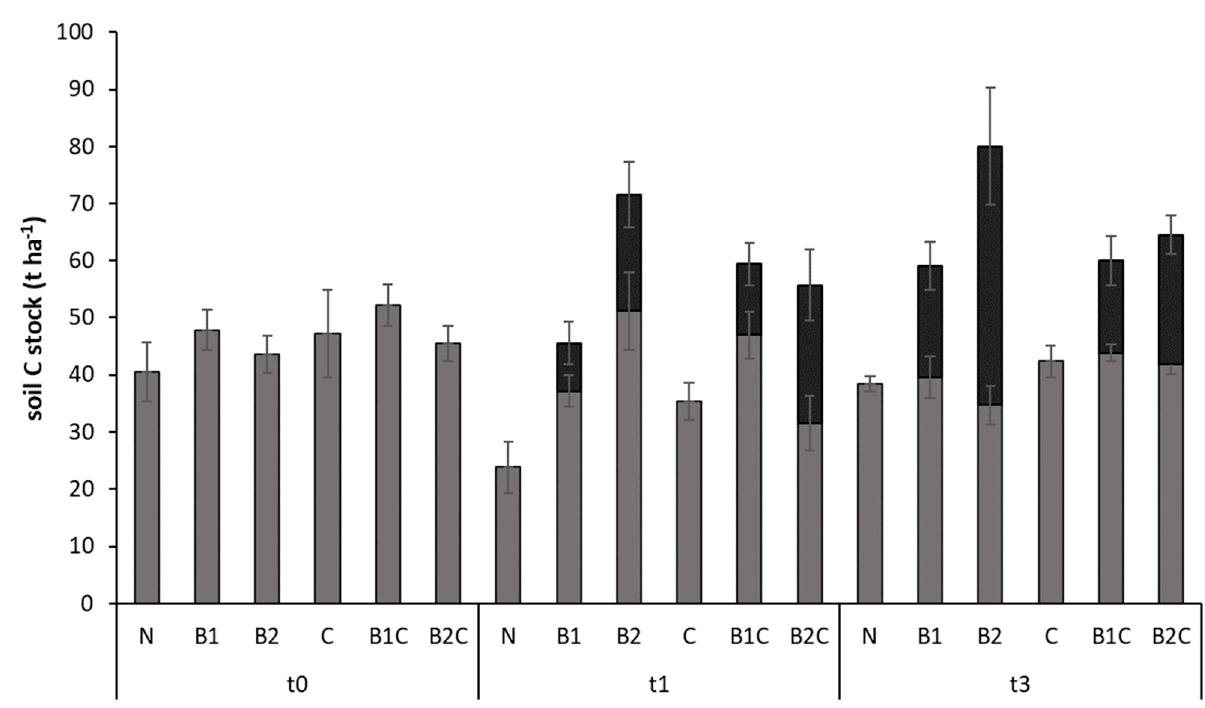
Figure 7. Soil C stock (t ha − 1 ) divided into biochar-C (black bars) and SOM-C (gray bars) as assessed with the BPCA method. C stocks are reported for six experimental treatments: N (control), B1 (25 t ha − 1 biochar), B2 (50 t ha − 1 biochar), C (45 t ha − 1 compost), B1C (25 t ha − 1 biochar + 45 t ha − 1 compost), and B2C (50 t ha − 1 biochar + 45 t ha − 1 compost) before the application of soil amendments (t0), 3 weeks later (t1), and 2 years later (t3). No statistically significant differences were observed. Vertical bars represent the standard error of the mean.